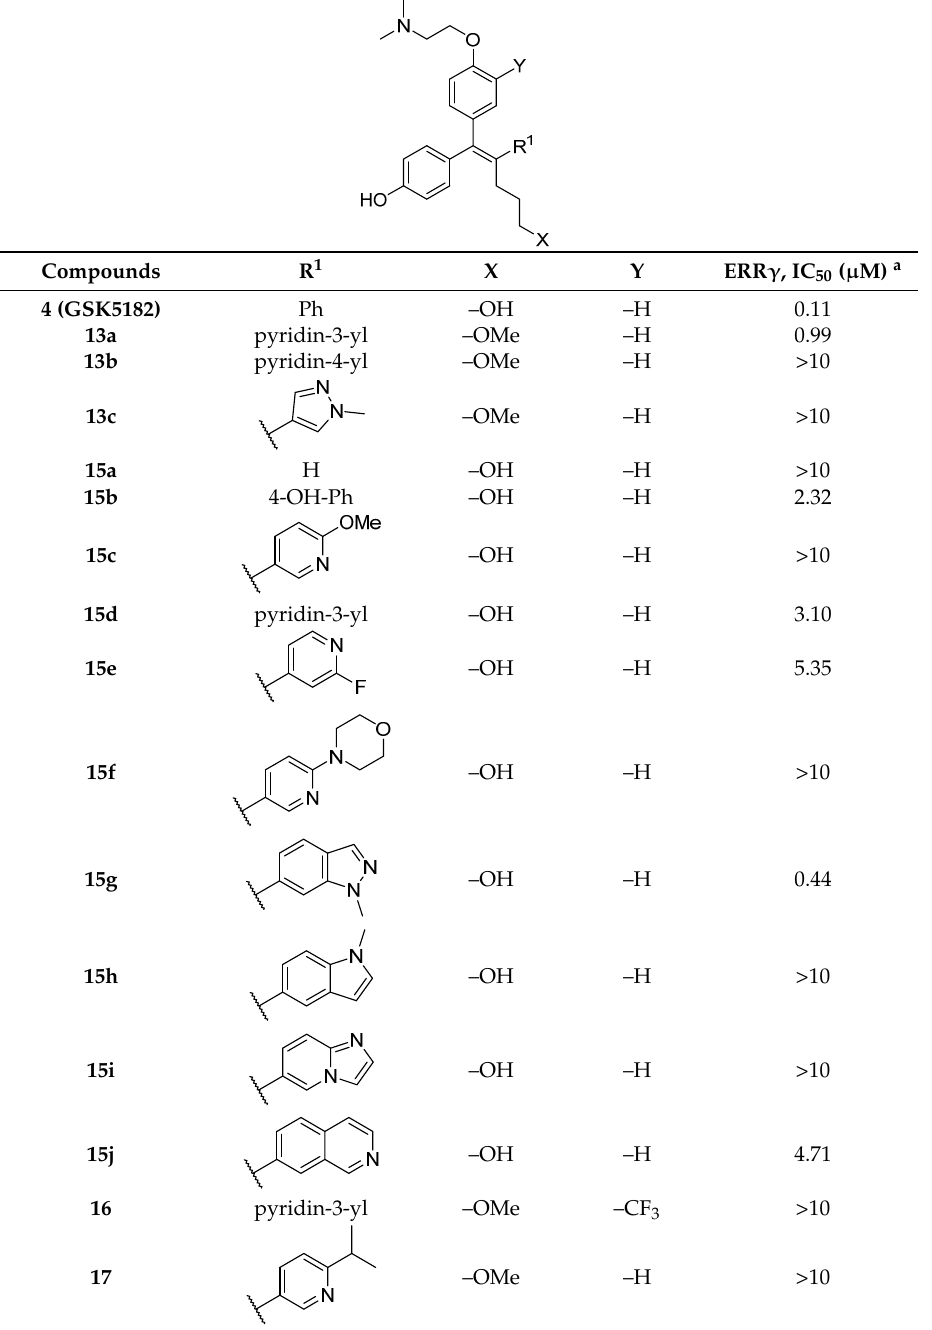
Table 1. ERR γ binding affinity screening of 16 analogs.